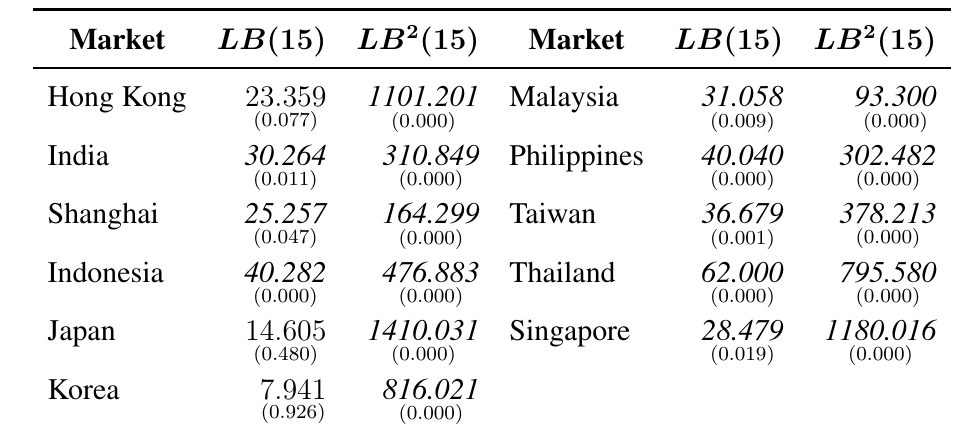
Table 5. Specification tests for the daily